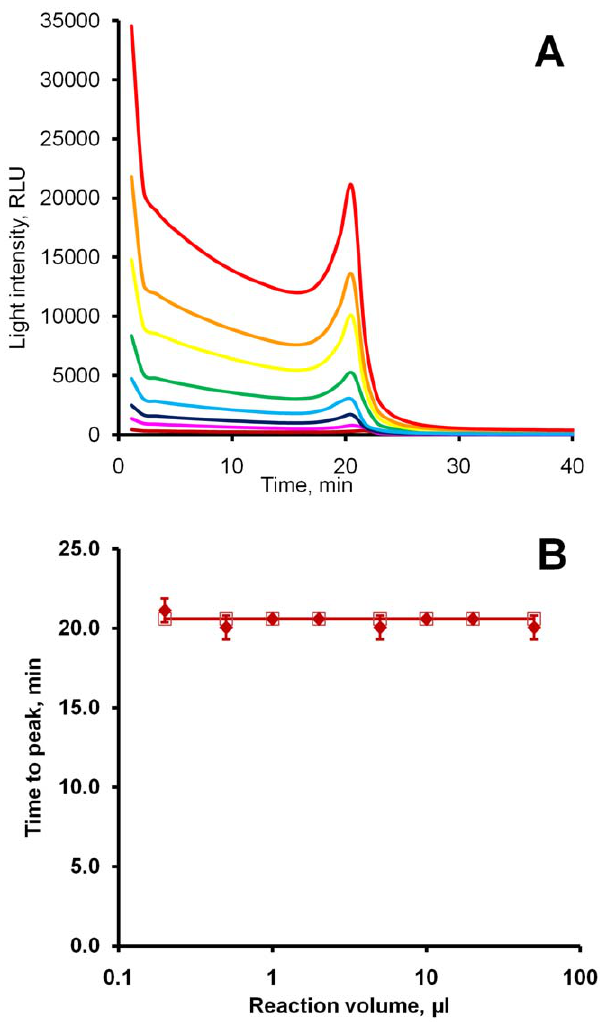
Figure 5. BART output in reactions of different volumes. (A) ChAT LAMP-BART curves recorded at 55 u C from reactions of different volumes containing the same concentration of the target. 50 m l – red, 20 m l – orange, 10 m l – yellow, 5 m l – green, 2 m l – light-blue, 1 m l – dark- blue, 0.5 m l – purple, 0.2 m l – brown. Each curve represents one of three replicates. (B) Graph of time to peak against the reaction